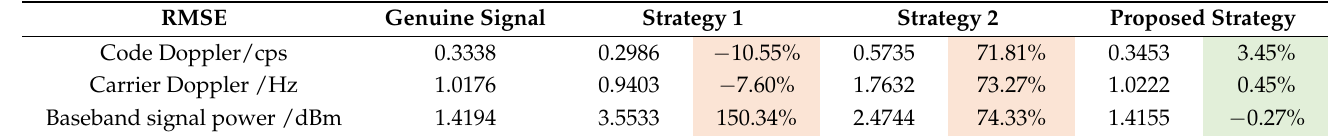
Table 8. Comparison of RMSE for different strategies and the genuine signal (C/N 0 = 50 dBHz, D = 0.2).